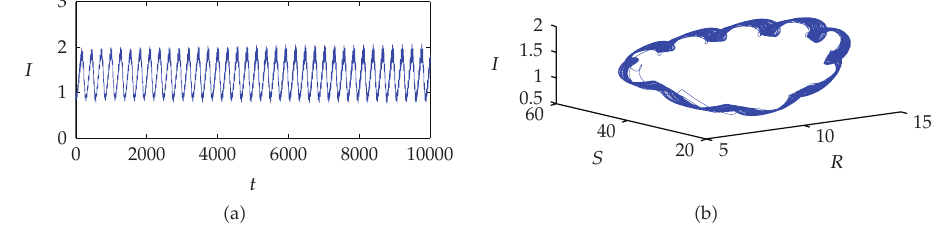
Figure 6: The parameters like in Figure 5 but τ (cid:8)